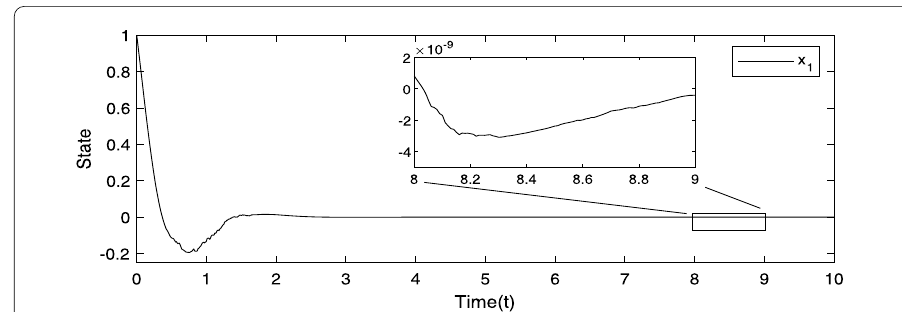
Figure 2 Response trajectory of x 1 for the open-loop systems with uncertainties